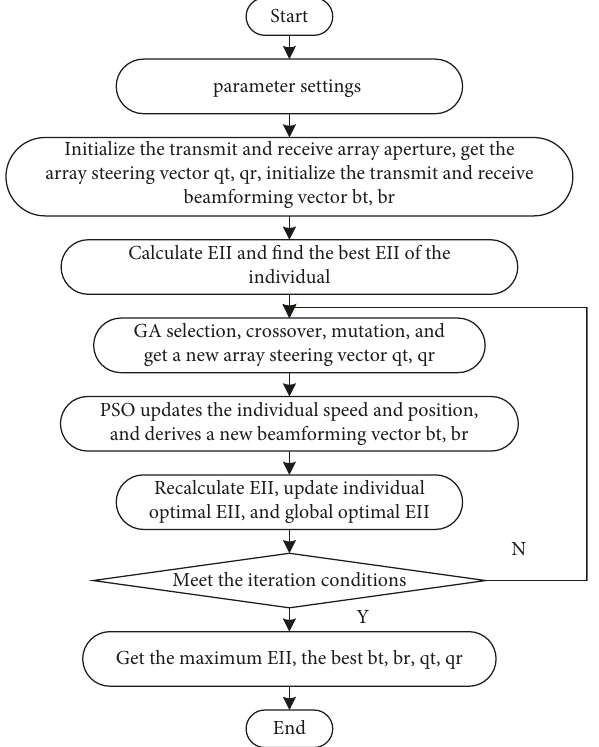
Figure 2: The flowchart of GA-PSO Hybrid optimized